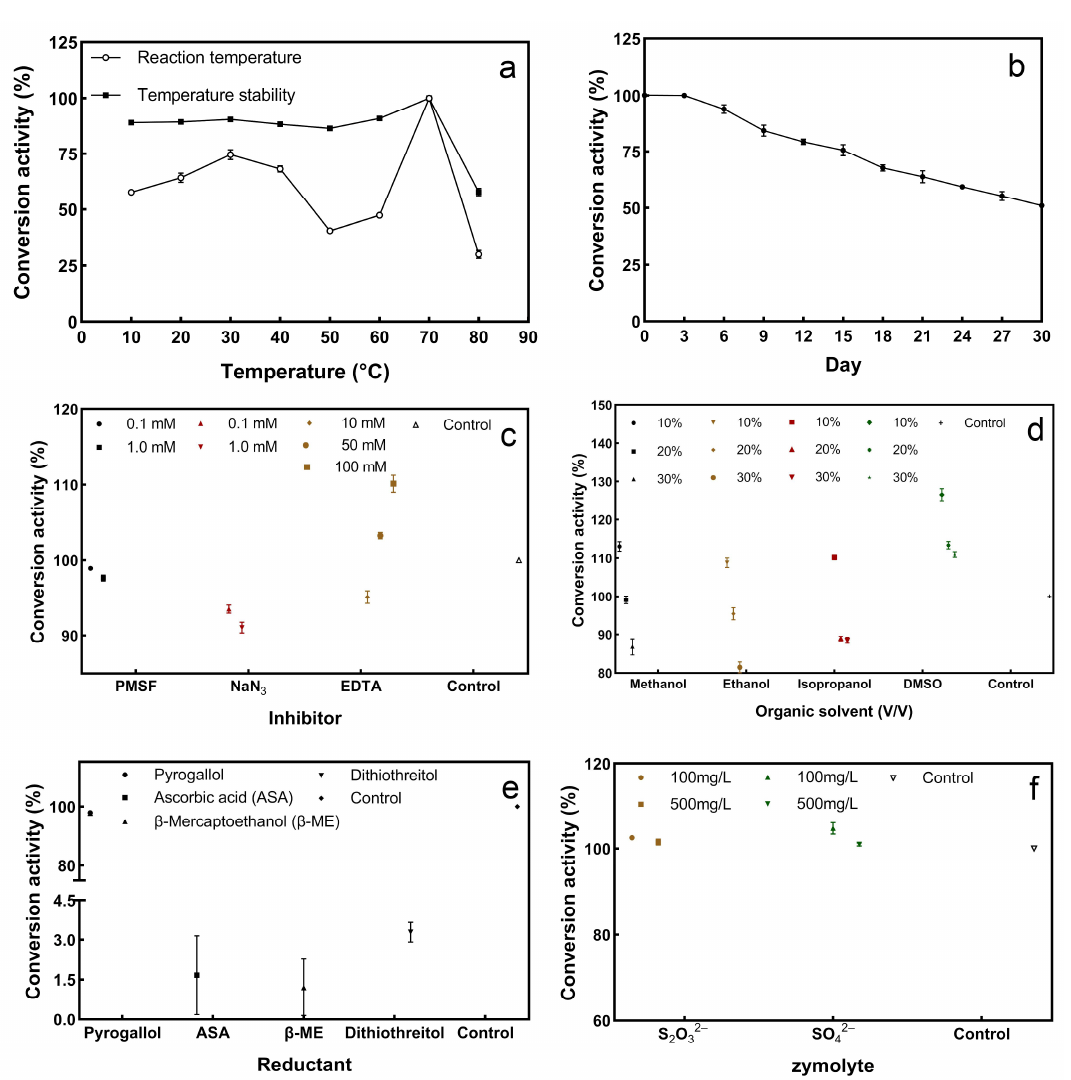
Figure 6. Effect of physiochemical factors on sulfur convertase activity: ( a ) the change in sulfur- converting-enzyme activity and stability at 10–80 ◦ C; the maximum enzyme activity was set at 100%, and this was used as a basis to calculate the relative enzyme activity at the other reaction temperatures, ( b ) sulfur convertase stability over storage time, ( c ) effect of inhibitors on sulfur convertase, ( d ) effect of organic solvents on sulfur convertase, ( e ) effect of reductants on sulfur convertase, ( f ) effect of zymolytes on sulfur convertase; the conversion activity of the control group was set to 100%, and this was used as a basis to calculate the relative activity of the enzyme under inhibitors, organic solvents, reductants, and